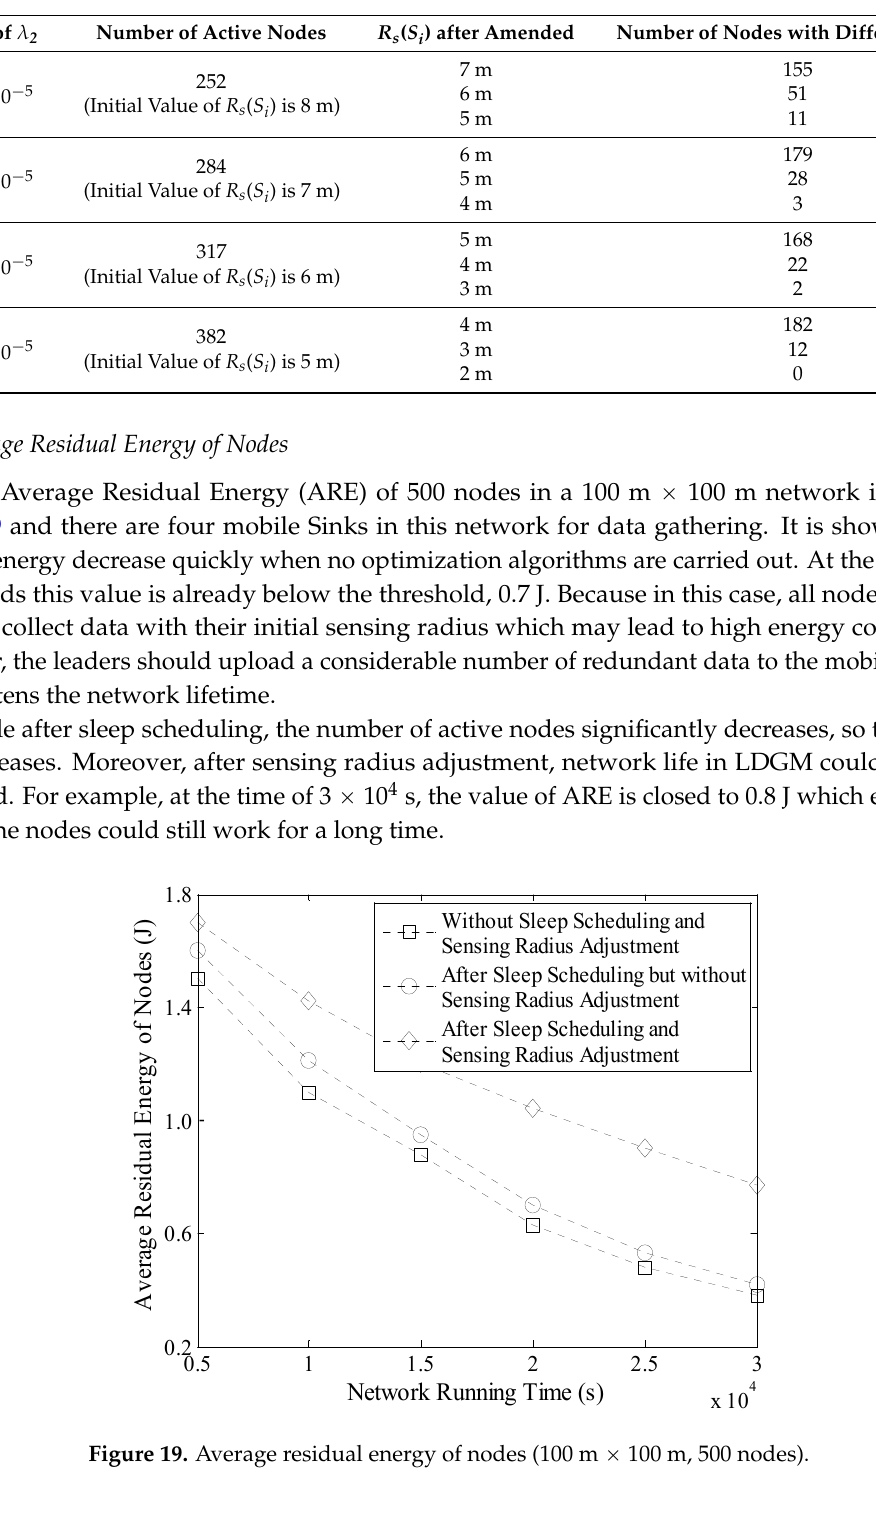
Table 4. Lengths of the sensing radius after adjustment.